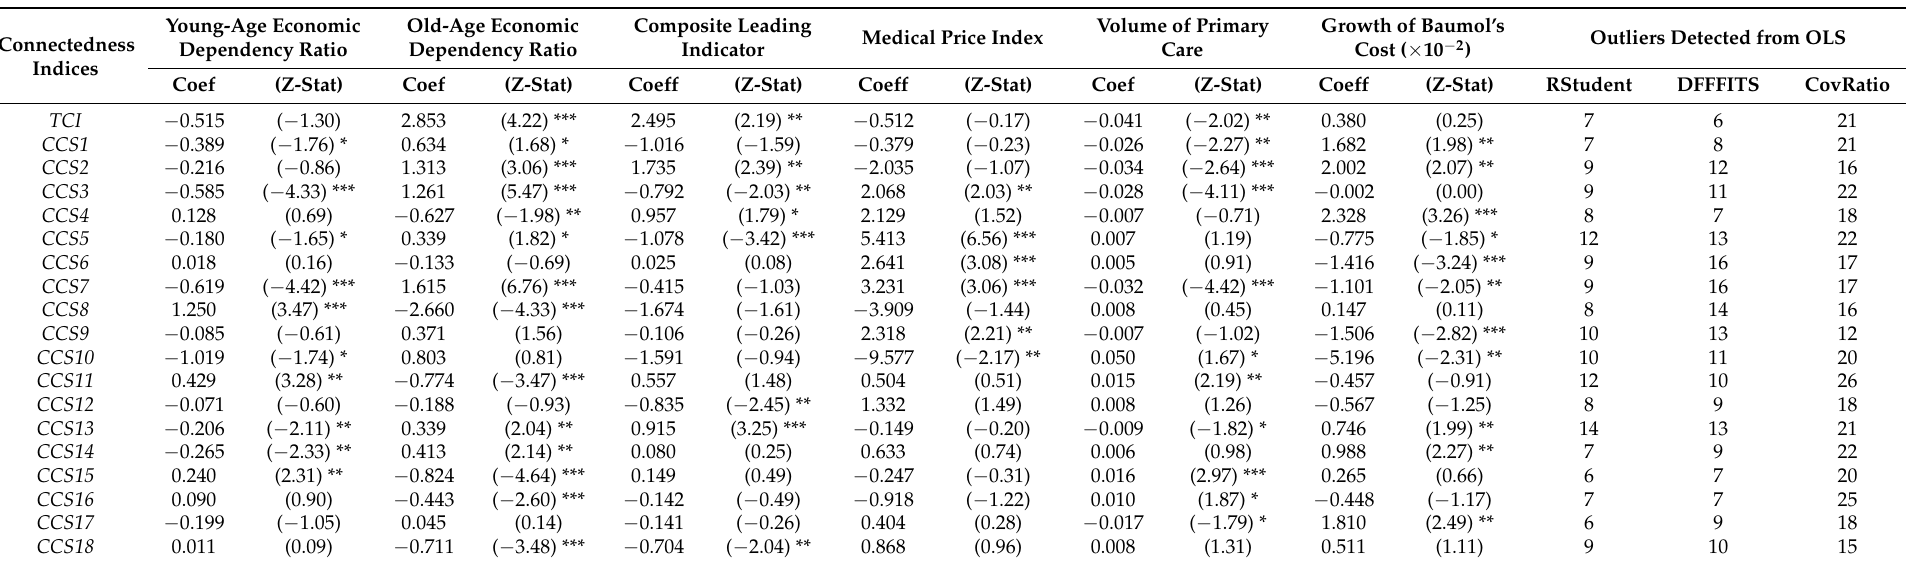
Table 1. Robust Least Square Estimates for Total Connectedness and Net Total Directional Connectedness